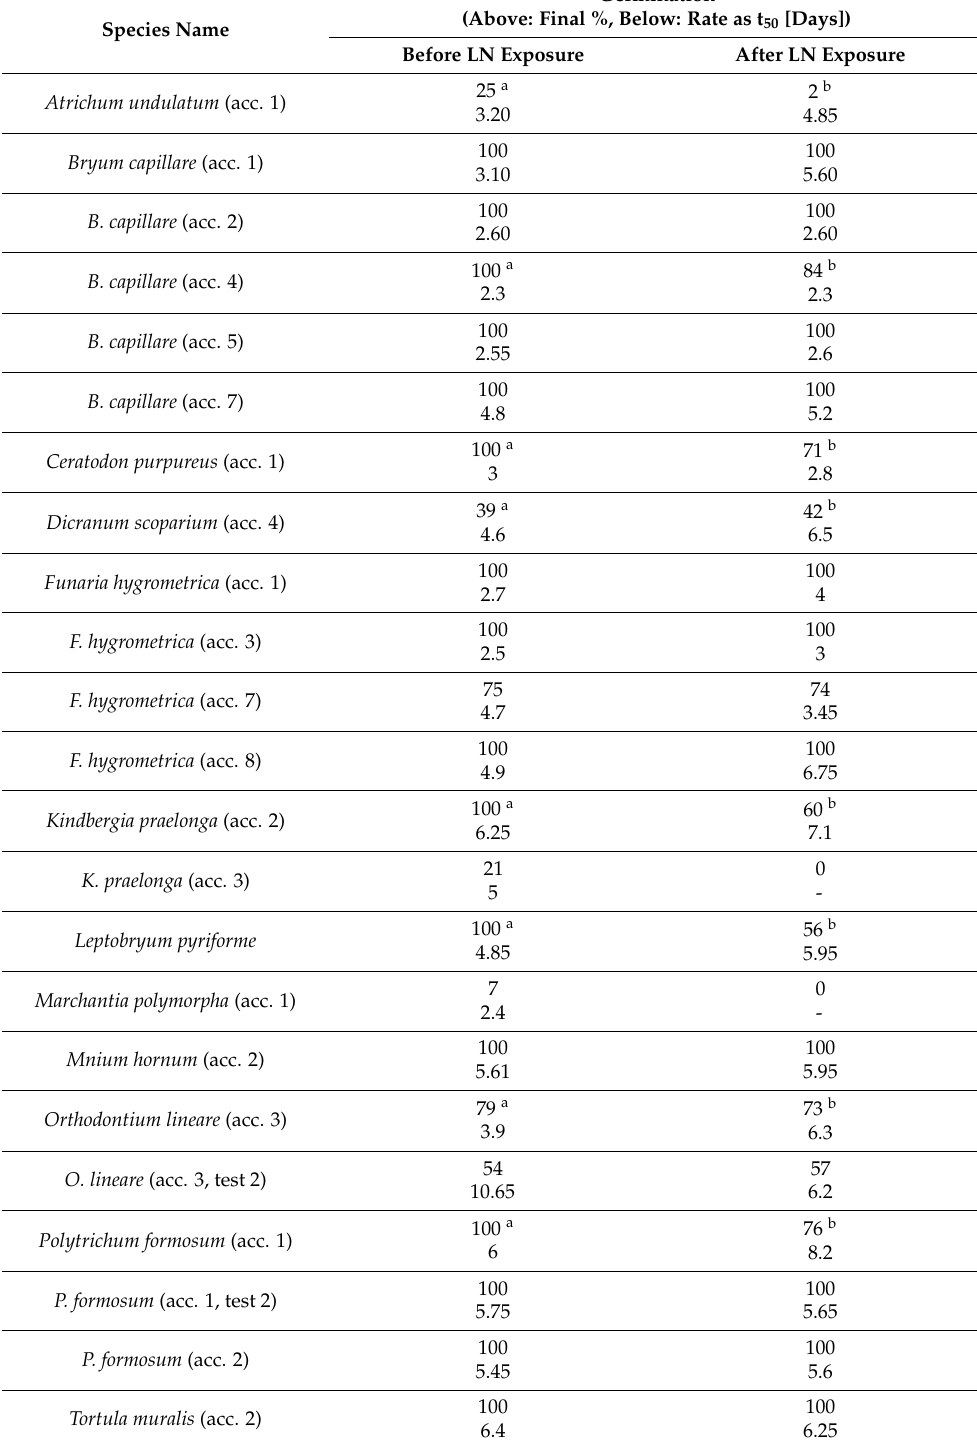
Table 1. Percentage and rate of germination of spores for the 23 bryophytes species assayed in this work. The final percentage (%) of germination was calculated as the maximum germination reached during the germination tests performed. The rate of germination was determined as the time (in days) by which spores reached 50% of the final germination percentage (t 50 ). Significant differences between germination % found in a proportion test ( p < 0.05) are represented by different